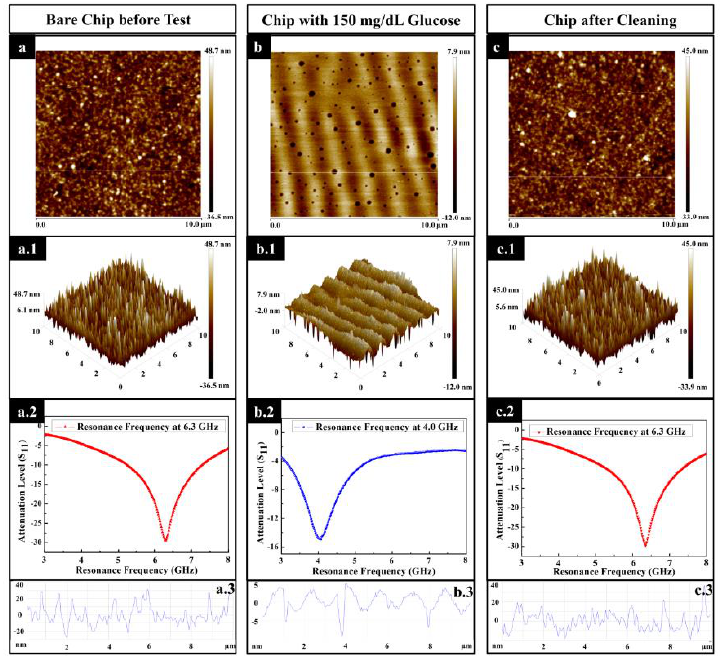
Figure 6. The analysis for surface morphology of the sensing area. ( a ) The 2D view of bare biosensor, ( a.1 ) the 3D view of bare biosensor, ( a.2 ) the RF measurement of bare biosensor, and ( a.3 ) the cross-sectional surface line profile of surface morphology for bare biosensor. Bare chip refers to the chip treated by a 3 min dry etching process. ( b ) The 2D view of biosensor with glucose concentration of 150 mg / dL, ( b.1 ) the 3D view of biosensor with glucose concentration of 150 mg / dL, ( b.2 ) the RF measurement of biosensor with glucose concentration of 150 mg / dL, and ( b.3 ) the cross-sectional surface line profile of surface morphology for biosensor with glucose concentration of 150 mg / dL. ( c ) The 2D view of biosensor after cleaning, ( c.1 ) the 3D view of biosensor after cleaning, ( c.2 ) the RF measurement of biosensor after cleaning, and ( c.3 ) the cross-sectional surface line profile of surface morphology for biosensor after cleaning. Table 2. Performances of the different measured resonance frequencies with various glucose concentrations ranging from 50 mg/dL to 500 mg/dL. S.N 1